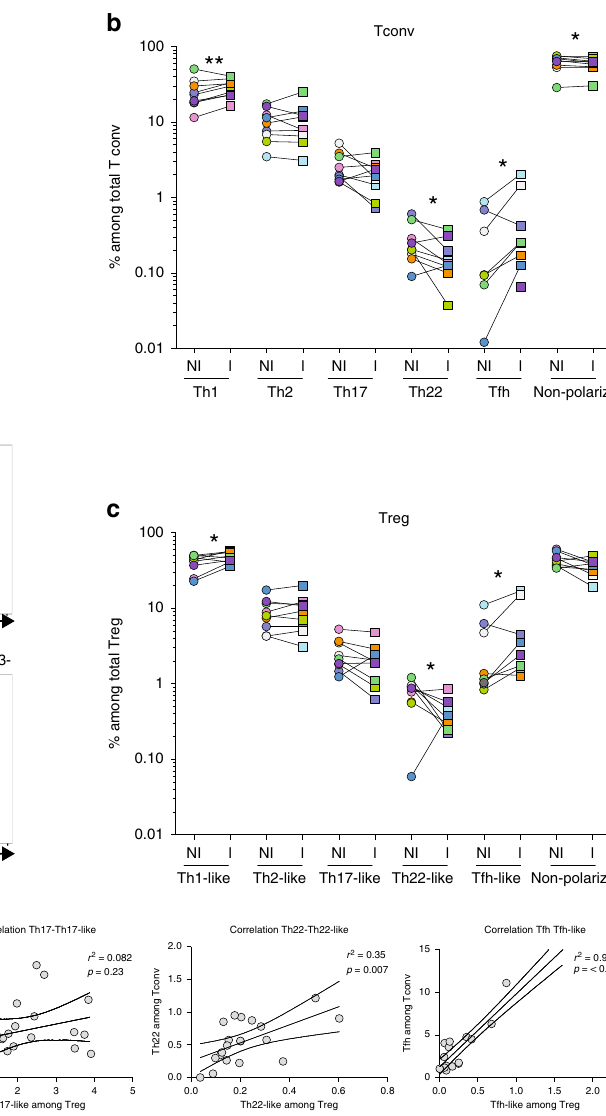
frequency of TCR- β CDR3s in each sample (Fig. 5a, c and Sup-